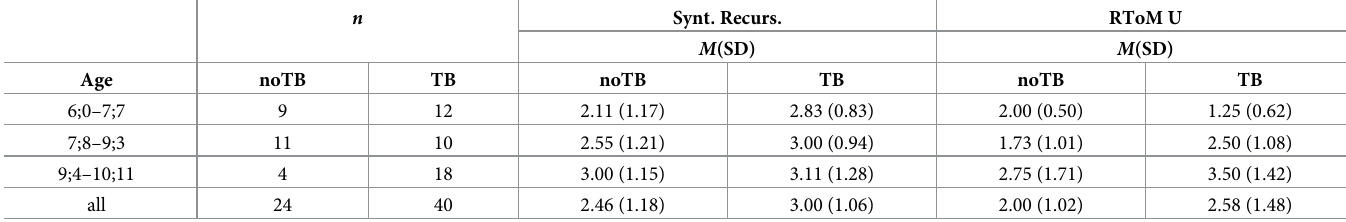
Table 7. Mean performance (M) and standard deviations (SD) in understanding of syntactic recursion (Synt Recurs.) and Recursive ToM Understanding (RToM_U) for TB non-passers and TB passers in three groups of age.